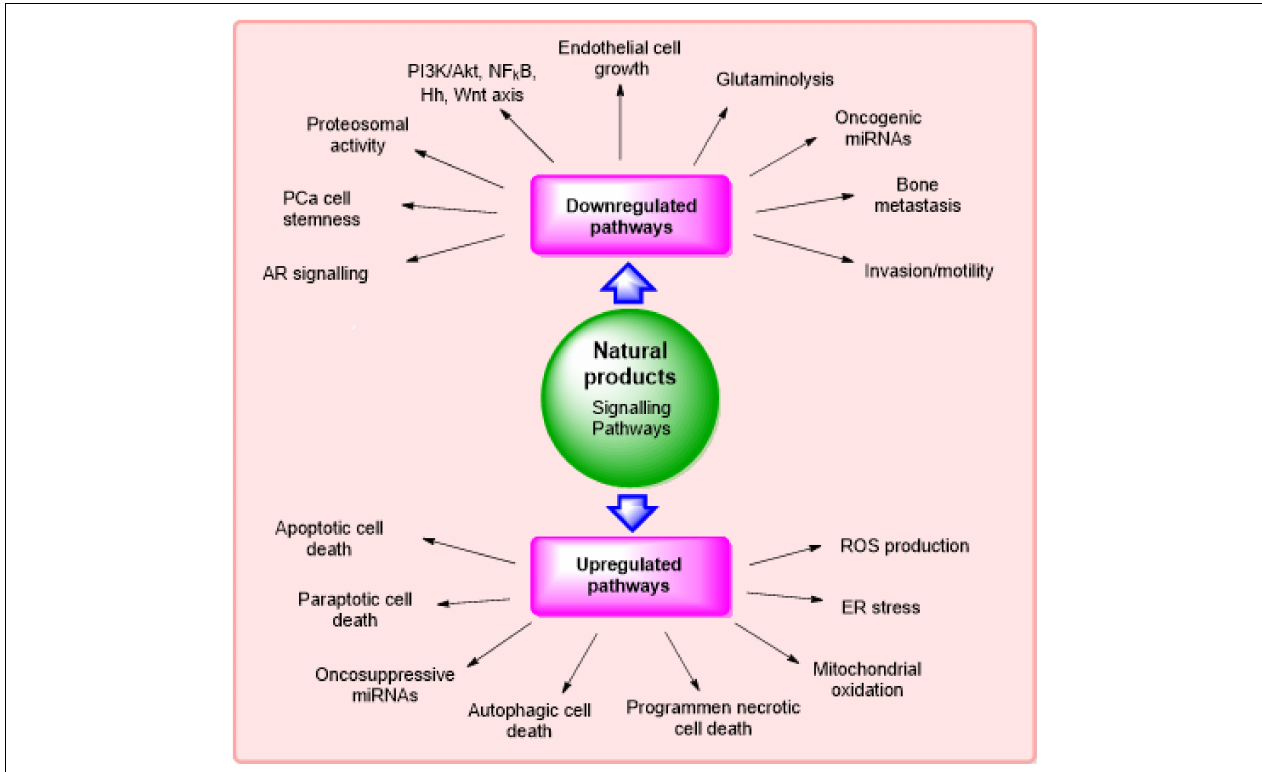
FIGURE 2 | Major signaling pathways modulated via phytochemicals in management of castration-resistant prostate cancer.